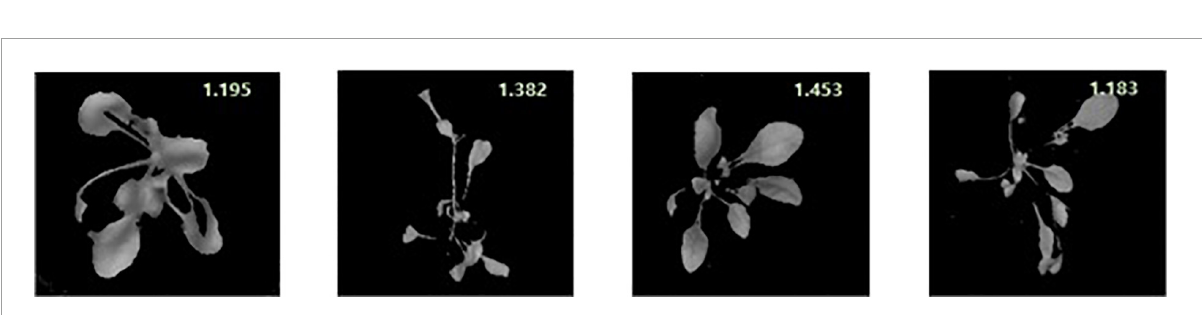
FIGURE6 Total phenolic content prediction of individual plants in a growing condition (RedBlue+Drought). The predicted value is given in the top-right corner of each image.